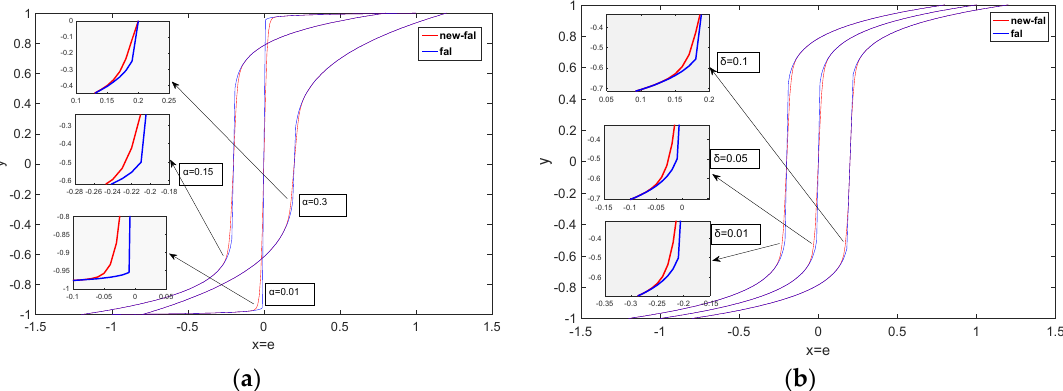
Figure 2. Comparison of characteristic curves of functions fal( ∙ ) and newfal( ∙ ) . In ( a ), α takes different values and in ( b ), δ takes different values.